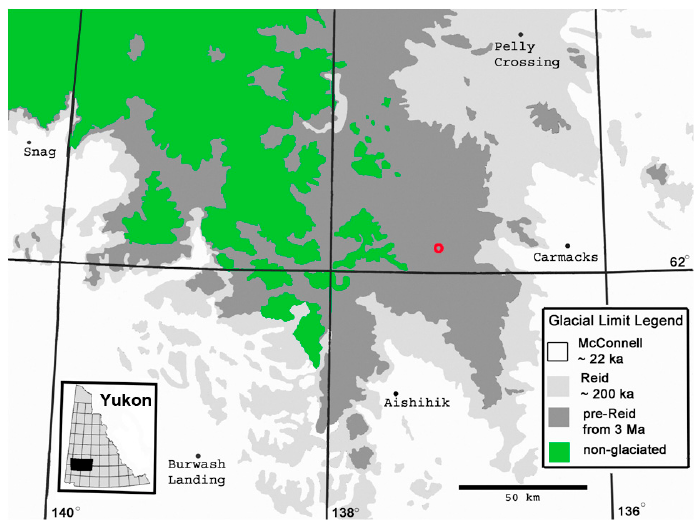
Figure 1. The red ‘o’ on this map indicates the location of the investigated site in the southeastern Dawson Range, approximately 47 km west of Carmacks, Yukon. This map shows the glacial limits achieved during the Last Glacial Maximum (LGM, or “McConnell”) and those in earlier known ice ages. Some researchers consider any terrain undisturbed by the LGM ice sheet to be within Beringia, whereas others view Beringia as never-glaciated terrain (coloured in green, but see